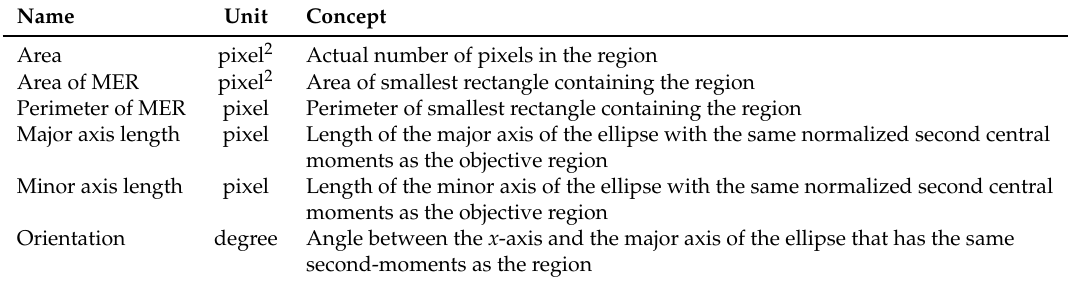
Table 4. Details of pixel shape indexes